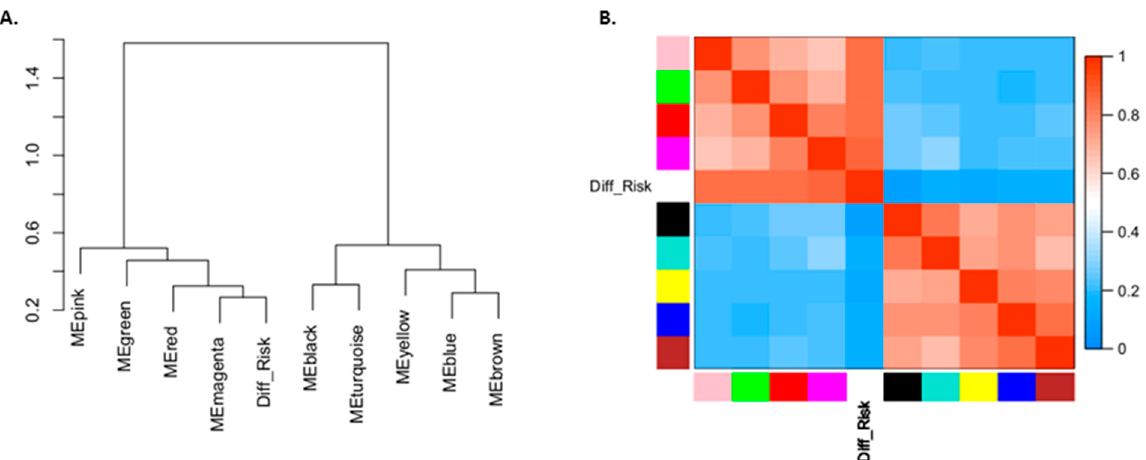
Figure 6. Visualization of the relationships between gene modules and risk of TMZ resistance. ( A ) In the dendrogram, pink, green, red, and magenta modules of genes were significantly correlated with TMZ resistance in recurrent tumor samples. ( B ) The heatmap further demonstrates that these four modules could be clustered together with samples having distinct TMZ resistance risks.